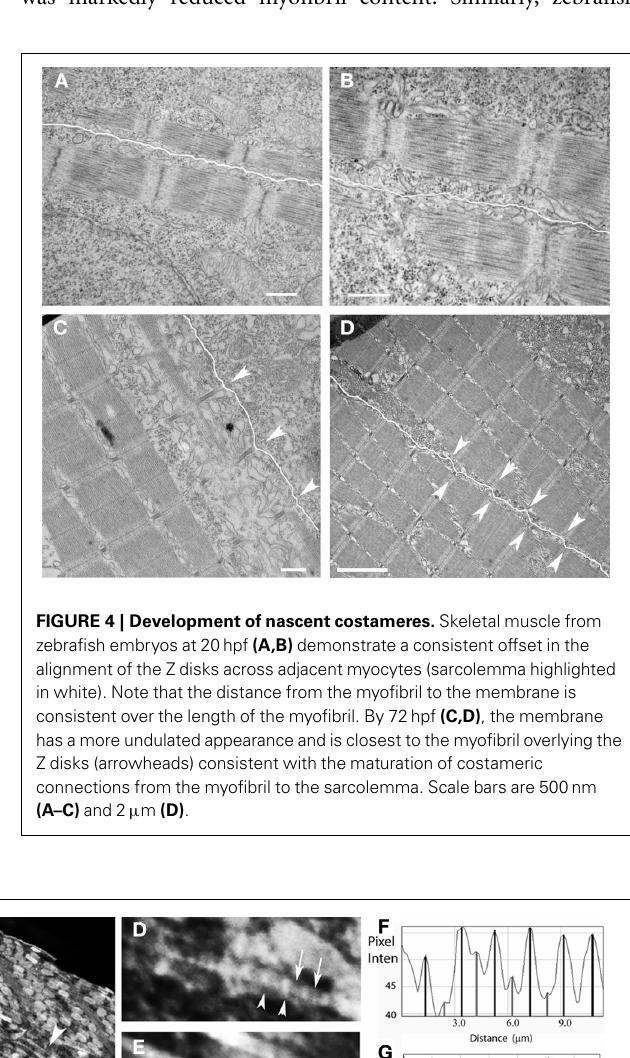
overlyingtheZdisk(arrowheads: D,E ).Frequentlyalowerabundanceandmore diffuse accumulation of β 1-integrin is noted at the mid A band (arrows: D,E ). Line scans assessing pixel intensity notes a regular pattern of β 1-integrin accumulation overlying the Z disks (black bars: F,G ) with frequent smaller accumulations in the mid (A) band (grey bars: F,G ). Note that, in general, the distance between Z disk accumulations of β 1-integrin is less between Z disks withoutaninterveningmid (A) bandaccumulation( F :farright; G :farleft).Scale bars are 50 μ m (A) , 20 μ m (B,C) and 5 μ m (D,E)